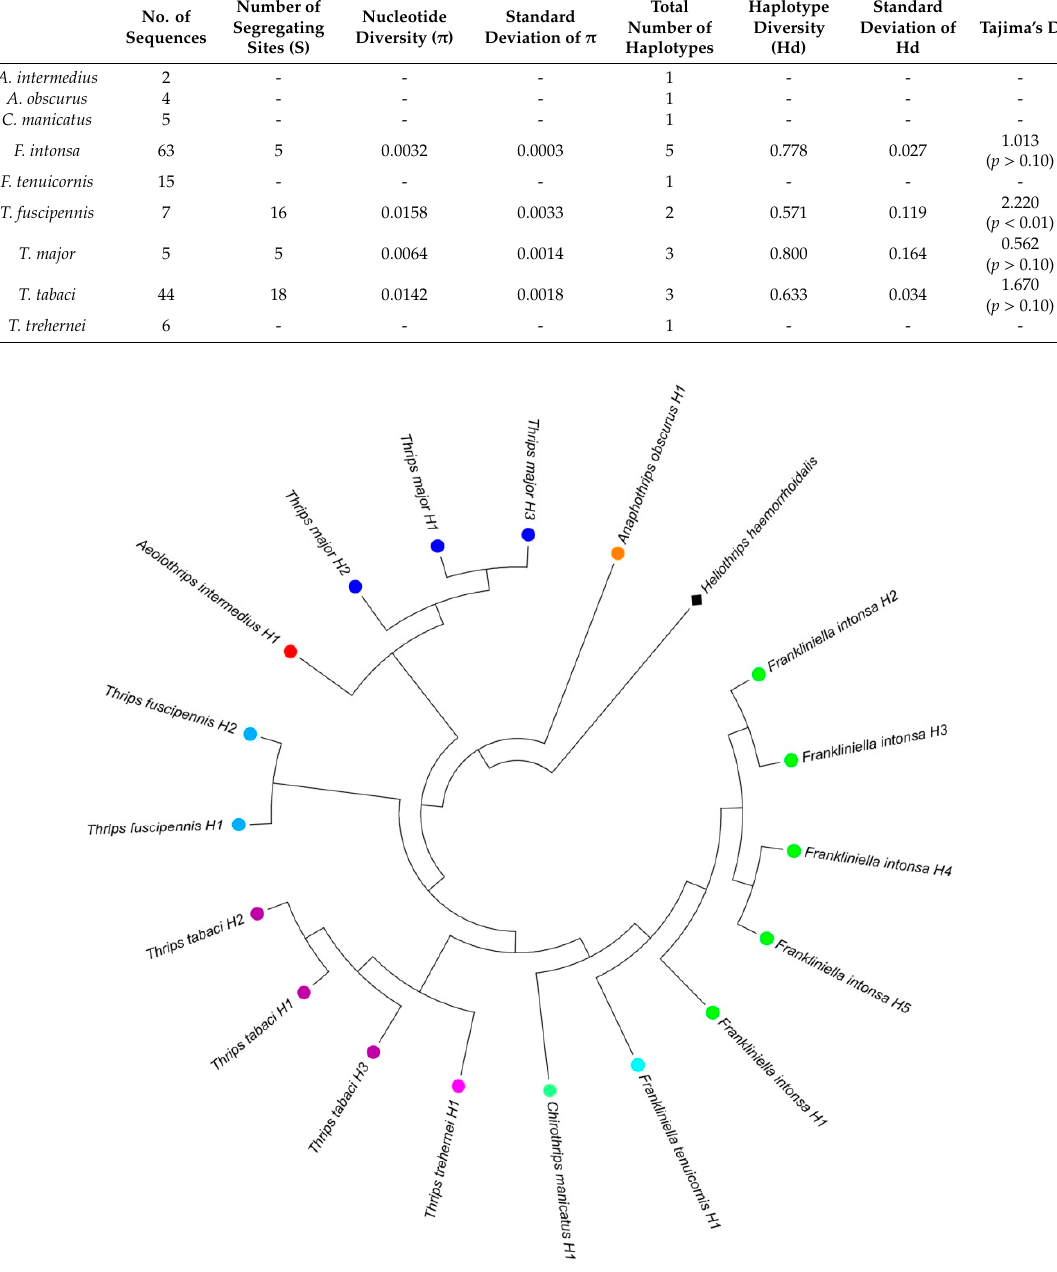
Figure 1. Bootstrap consensus tree generating with maximum likelihood (ML) method and general time reversible (GTR) G + I model showed the genetic relationship among the isolated thrips species obtained by COI sequences. Each species was highlighted with a di ff erent color. Heliothrips haemorrhoidalis (MK484663.1) was used as